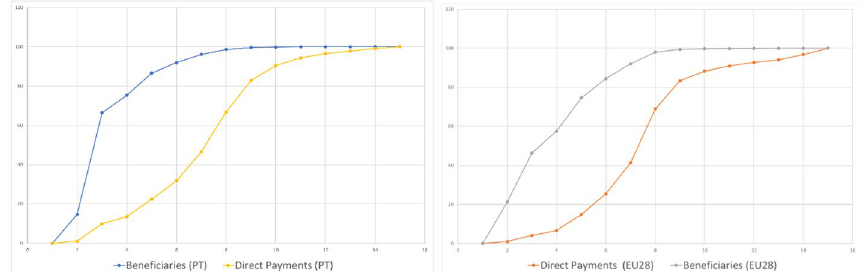
Fig. 1 Lorenz curves referring to the distribution of direct payments in Portugal (left) and in the EU28 (right) ( Source : European Commission and authors’ calculations)